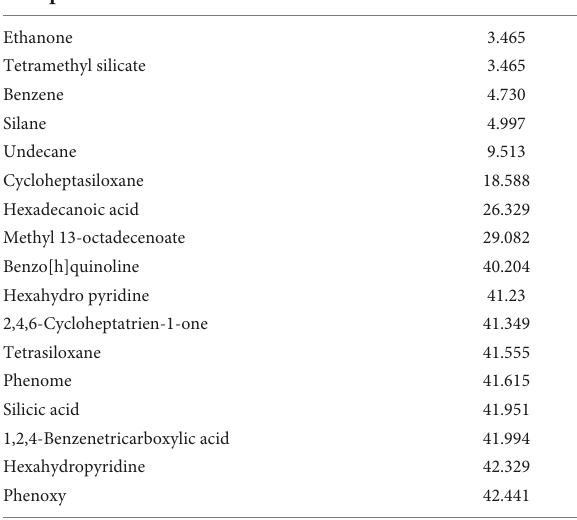
TABLE 2 Gas chromatographic analysis of leaf extracts of P. dactylifera. Compounds Retention time